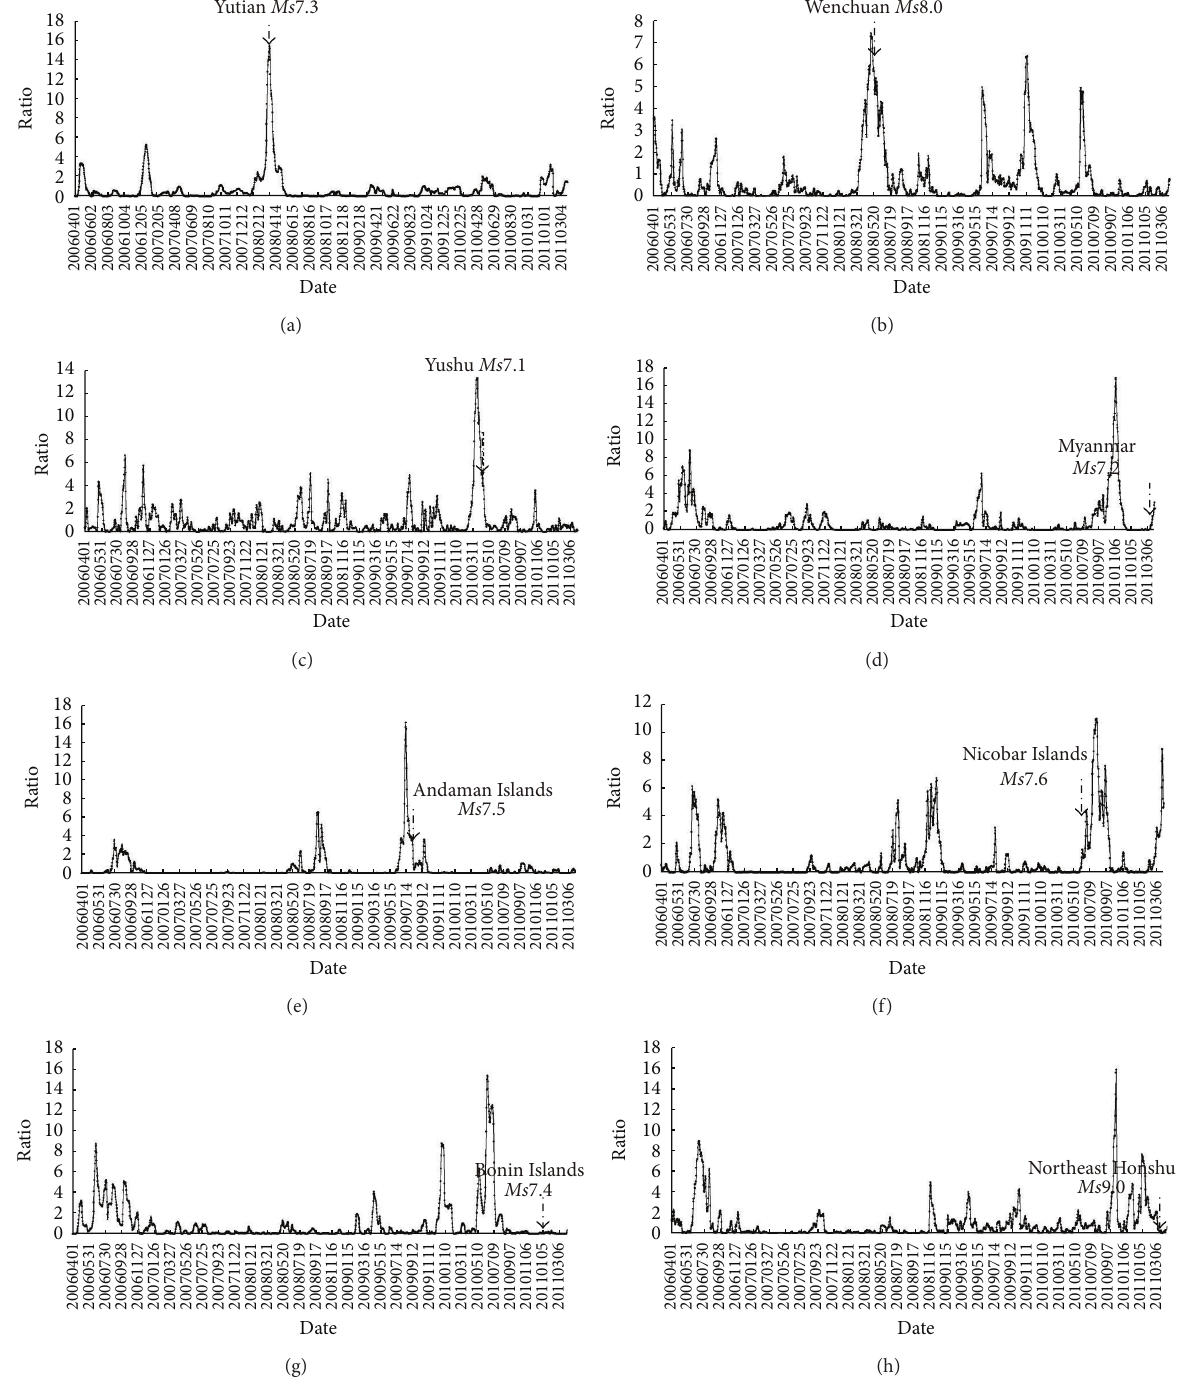
Figure 8: Time series curve of earthquakes. ((a) Yutian Ms 7.3 earthquake, characteristic period of the anomalies is about 64 days; (b) Wenchuan Ms 8.0 earthquake, characteristic period of the anomalies is about 13 days; (c) Yushu Ms 7.1 earthquake, characteristic period of the anomalies is about 13 days; (d) Myanmar Ms 7.2 earthquake, characteristic period of the anomalies is about 13 days; (e) Andaman Islands Ms 7.5 earthquake, characteristic period of the anomalies is about 16 days; (f) Nicobar Islands Ms 7.6 earthquake, characteristic period of the anomalies is about 32 days; (g) Bonin Islands Ms 7.4 earthquake, characteristic period of the anomalies is about 64 days; (h) Northeast Honshu Ms 9.0 earthquake, characteristic period of the anomalies is about 13